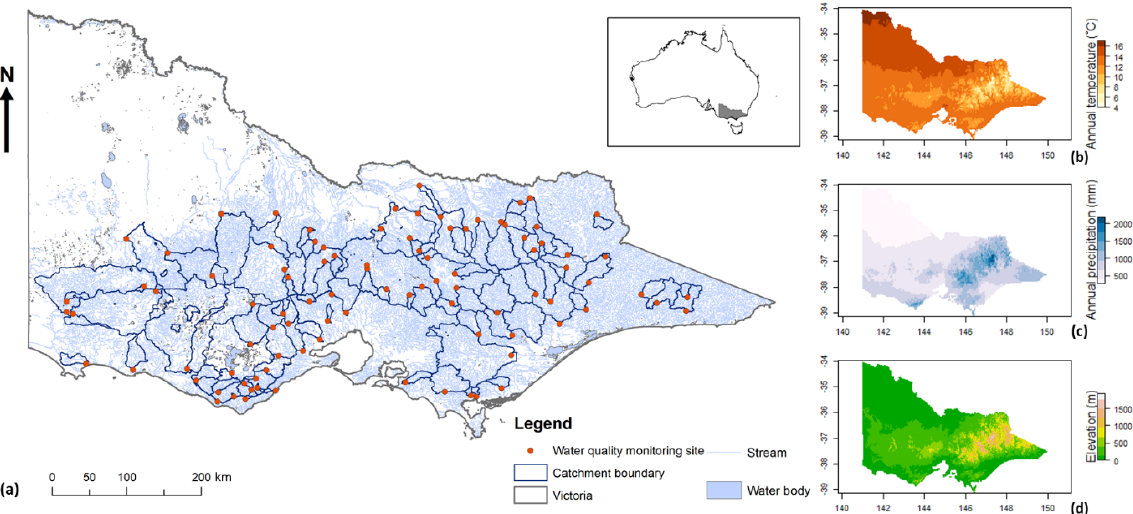
Figure 1. Map of (a) the 102 selected water quality monitoring sites and their catchment boundaries, with the inset showing the location of the state of Victoria within Australia. Maps of (b) the average annual temperature, (c) the annual precipitation and (d) the elevation across